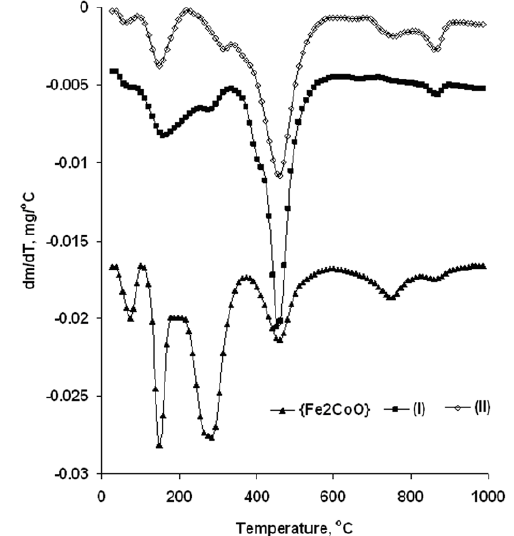
Figure 3. DTG curves of investigated compounds, {Fe and II